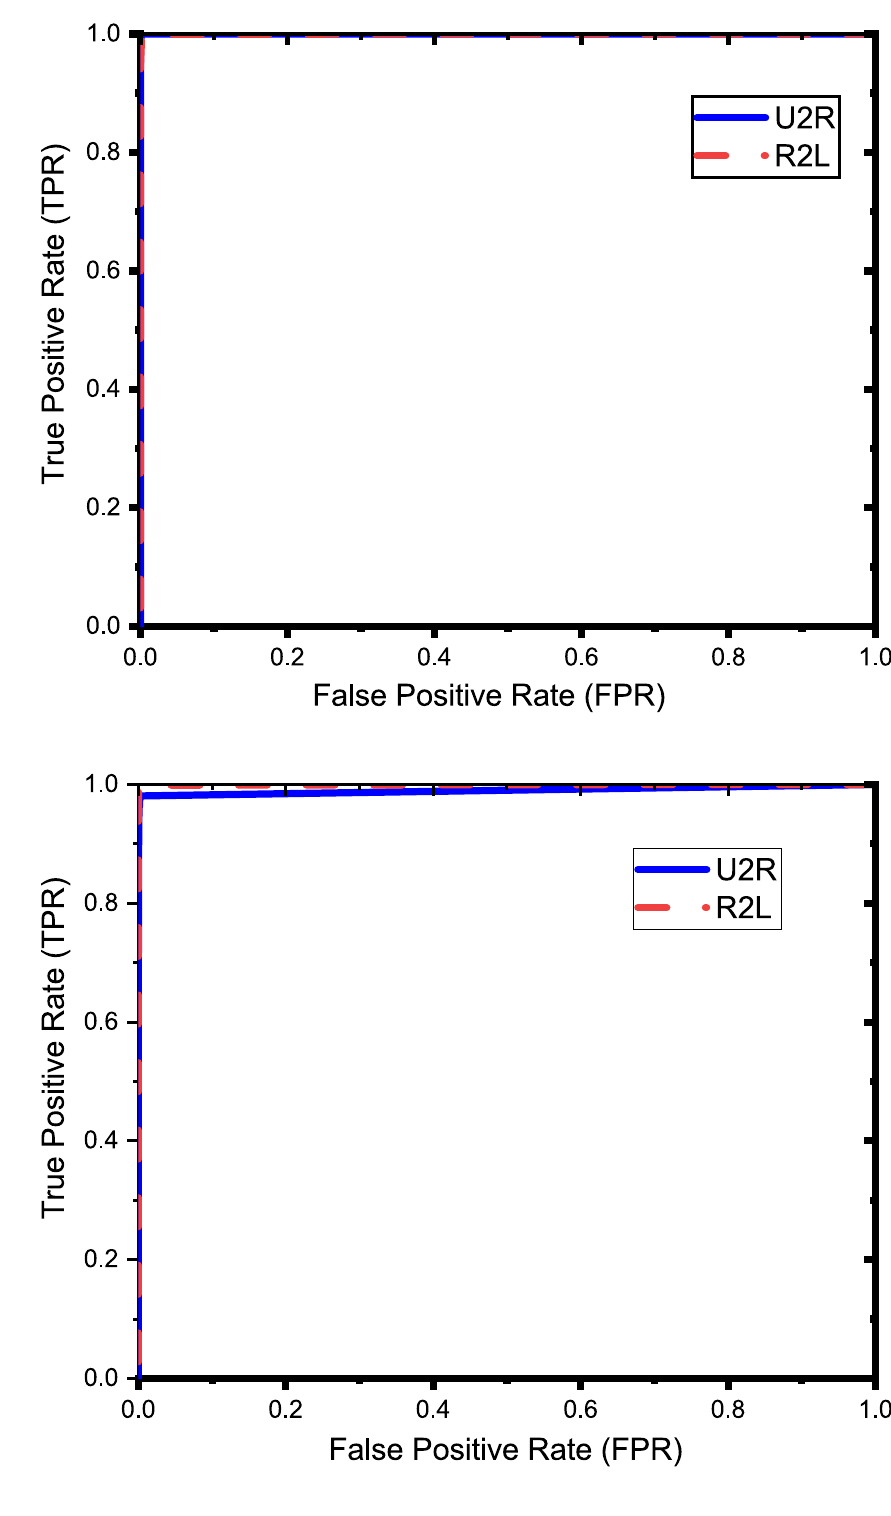
Fig. 6 The ROC curve of random forest classifier with the SMMO-CoFS method for the extreme minority classes U2R and R2L